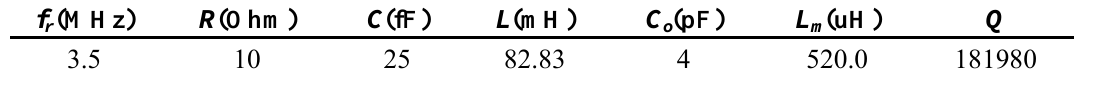
Table 1. Quartz data for resonant frequency 3.5 MHz